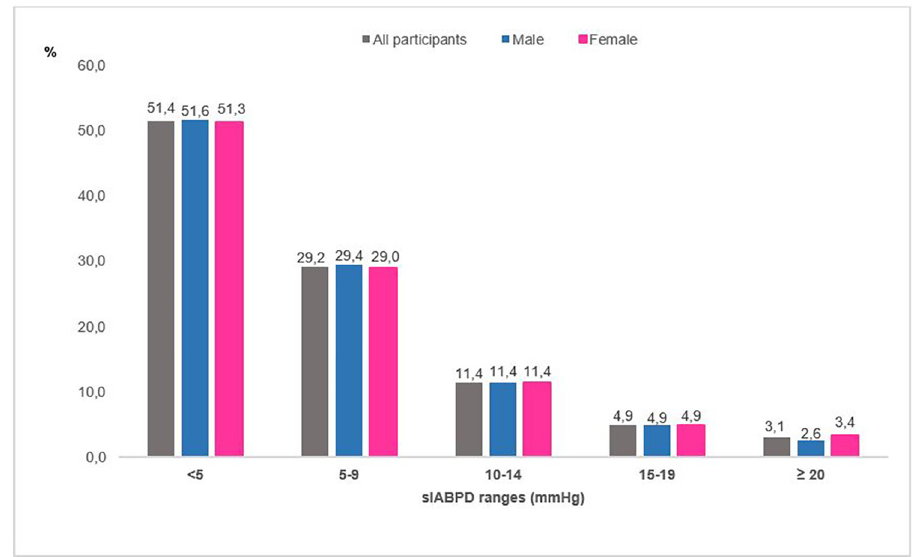
Fig 2. Distribution of absolute systolic inter-arm blood pressure difference (sIABPD) by gender, TAHES study, Benin 2020.